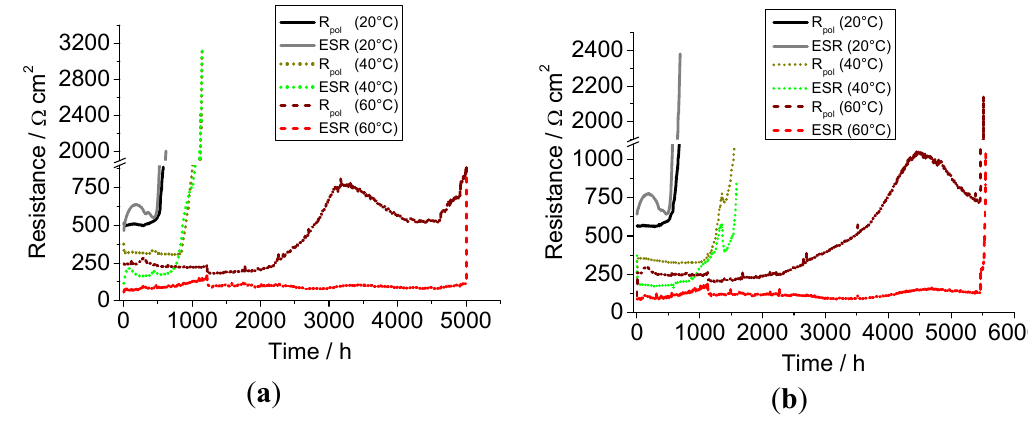
TFSI-0.1 LiTFSI /Li fresh cells subjected to 14